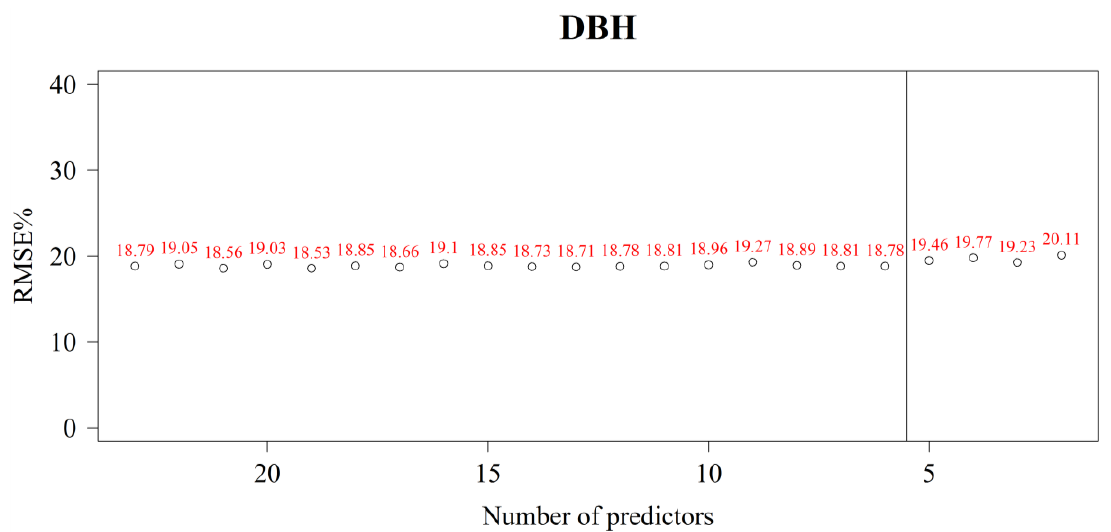
Figure 4. Effect of number of predictors to DBH estimation accuracy in and selection of ALS features for the park (northern part of the study